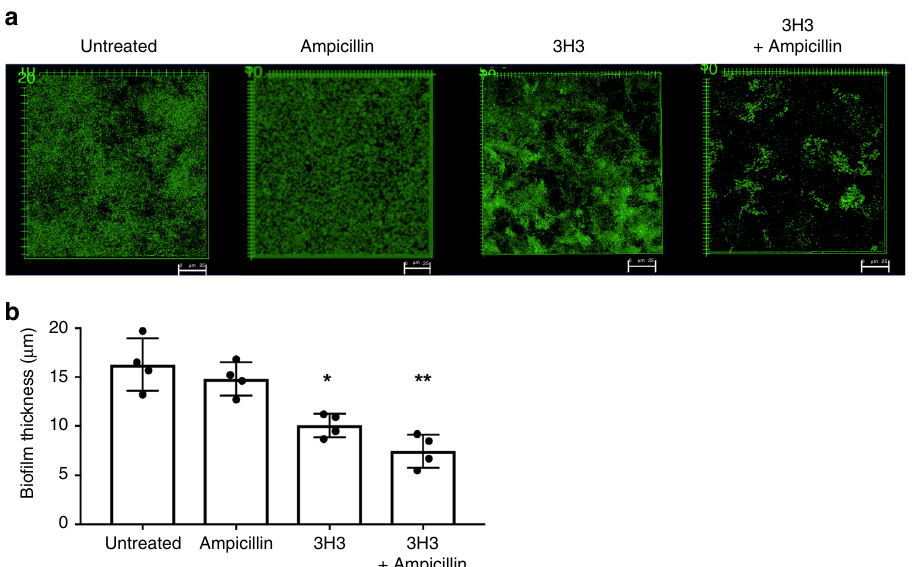
Fig. 4 Synergistic effect of 3H3 and antibiotic reduces S . Typhimurium bio fi lm. a S . Typhimurium bio fi lms were untreated or were incubated in the presence of 0.5 mg/ml control antibody 6A or 0.5 mg/ml 3H3. After 48 h, bio fi lms were subjected to 30 μ g/ml ampicillin or not for an additional 24 h. Bio fi lms were stained with Syto9 (green), washed extensively, and visualized using Leica TCS confocal microscopy at ×63. Scale bars represent 25 μ m. b Bio fi lm thickness ( μ m) was determined from z-stacks using Leica TCS software. Mean and SE were calculated from results from at least three independent experiments. * p < 0.05, ** p < 0.01 as determined by Student ’ s t